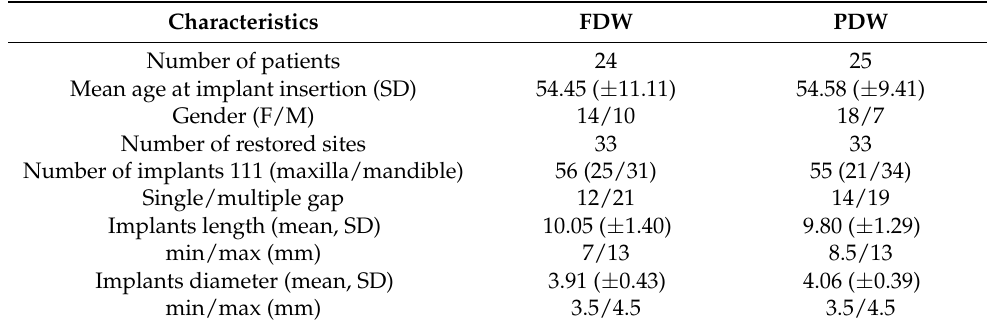
Table 1. Characteristics of evaluated groups. Characteristics